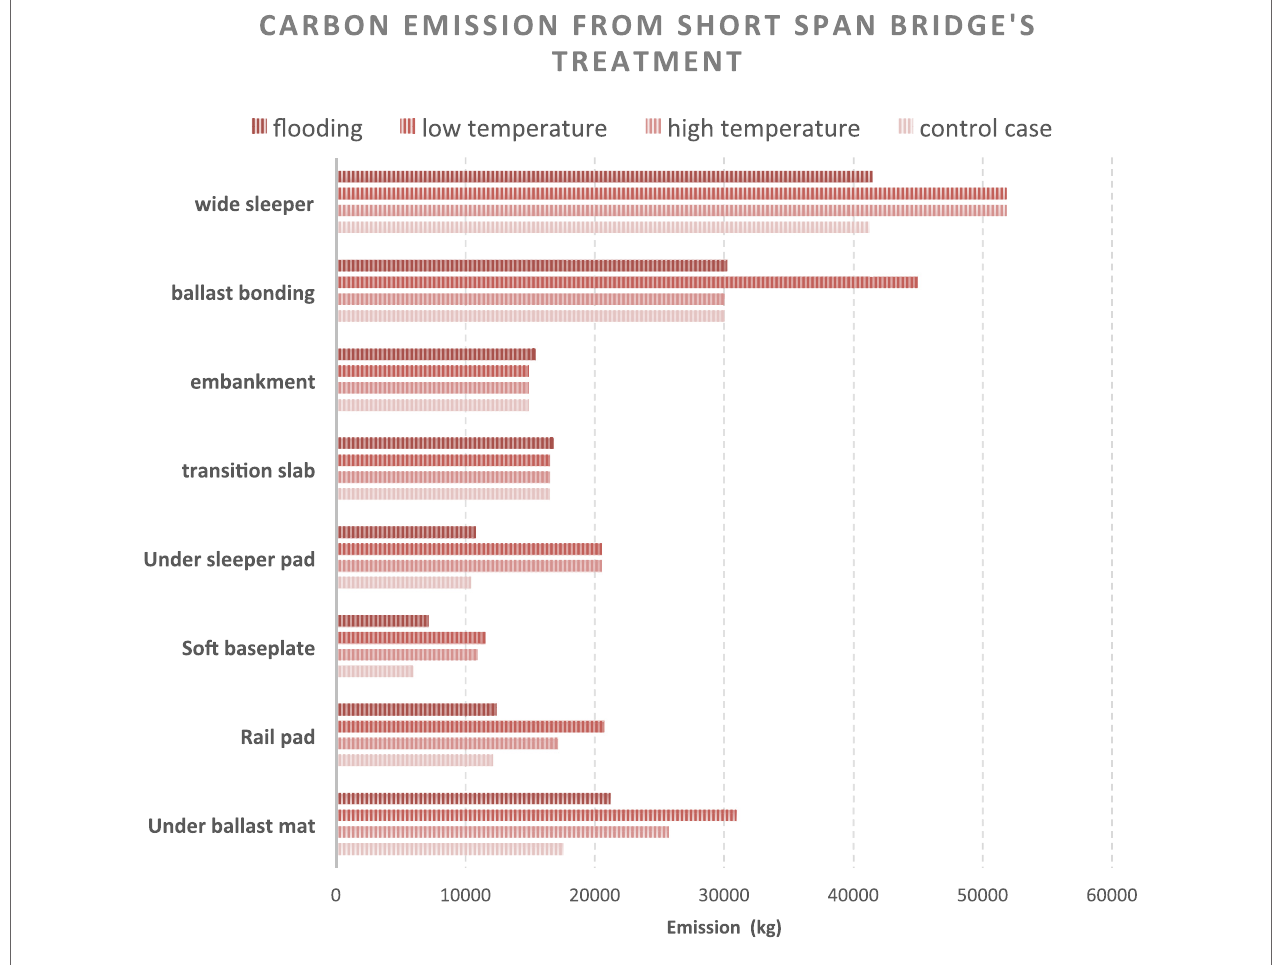
Figure 8 | Carbon emission from short-span bridge ends treatment and maintenance in different